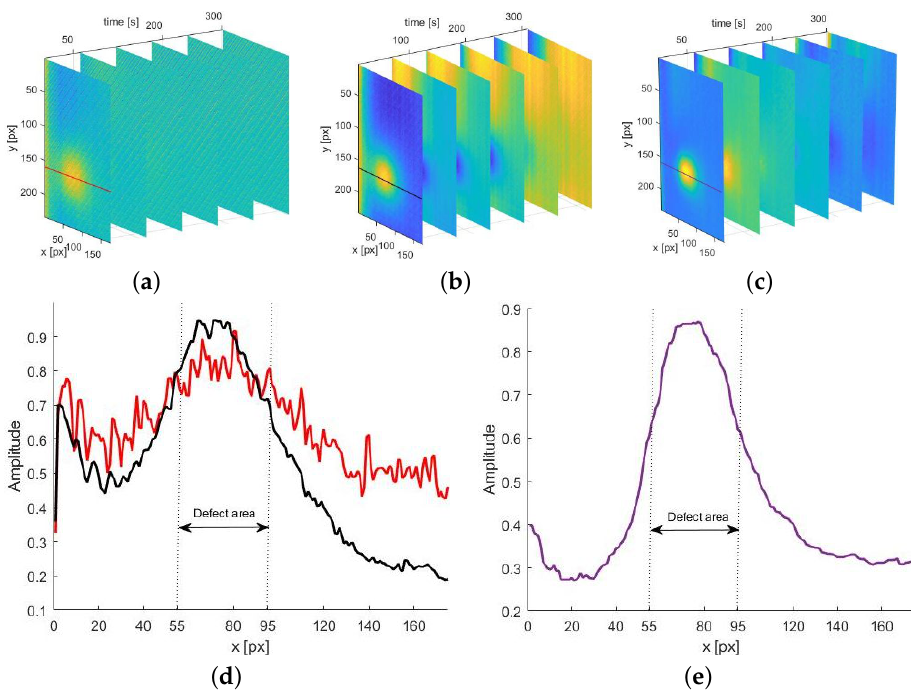
Figure 6. The results of the process of fitting the approximation curves obtained for the chosen defect ( φ of 4 mm and D of 18 mm): set of the resulting sequences for the defect: ( a ) A I ( b ), A D ( c ) A Res ; comparison of distribution of values along the line crossing the defect obtained for corresponding images in a sequences of: ( d ) A I (red line), A D (black line), and ( e ) A Res . The dashed lines depicting the defect area correspond to the real localization of defects in the examined